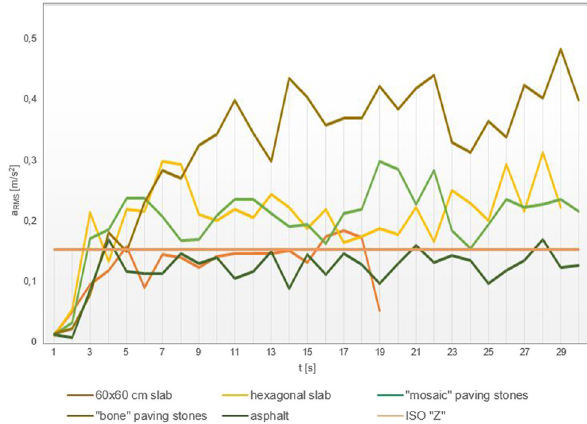
Figure 8: Variation in time of the amplitude vibration acceleration a RMS ( m/s 2 ) ( with the ISO comfort limit marked ) during the passage of a disabled person in an active wheelchair on di ff erent surfaces – fi ltration with a 1/3 octave fi lter 12.5 Hz, direction “ Z . ”